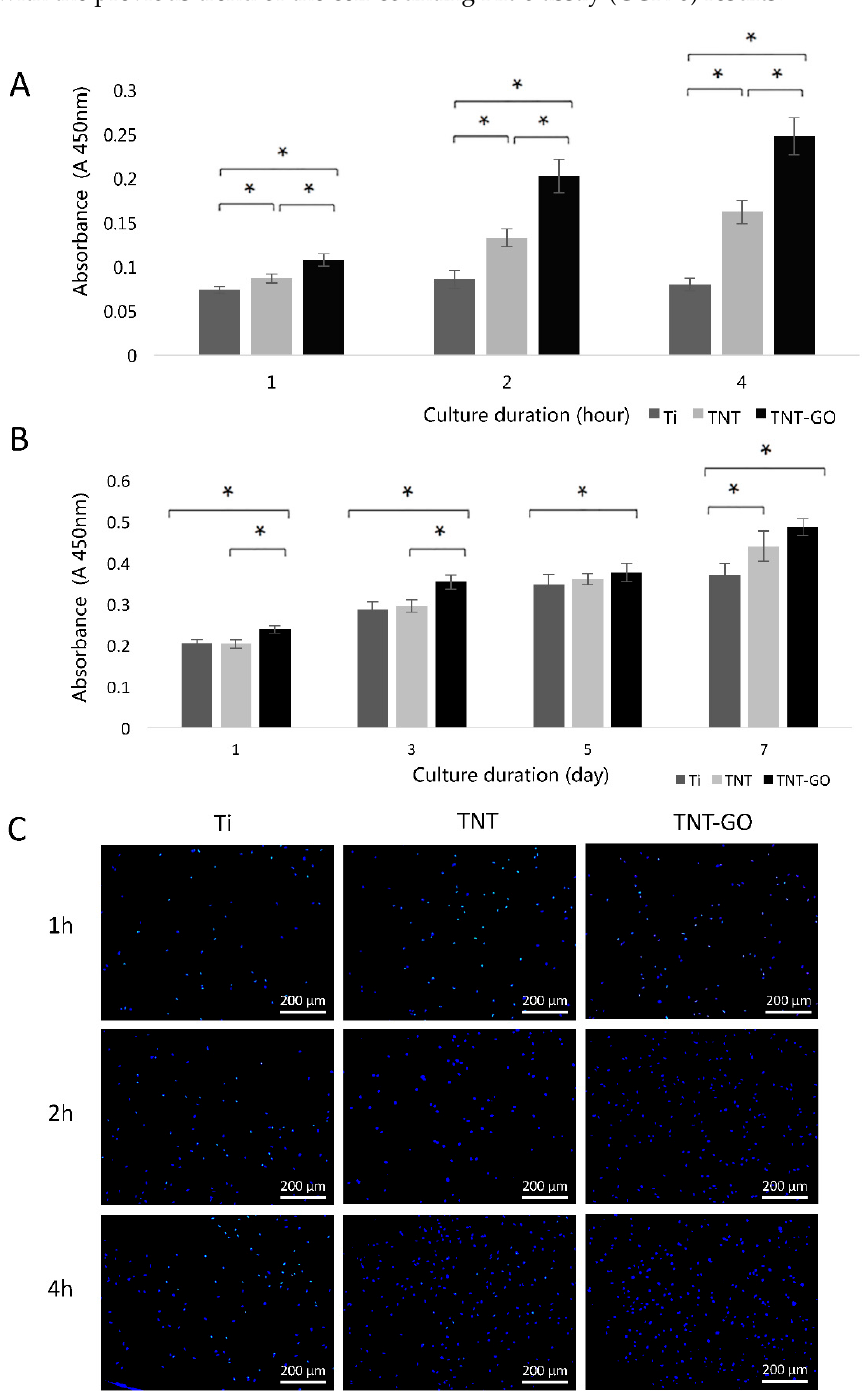
Figure 3. ( A ) Cell adhesion of human gingival fibroblasts (HGFs) on the samples after 1, 2, and 4 h. ( B ) Cell proliferation of HGFs after 1, 3, 5, and 7 d. ( C ) DAPI staining of adherent HGFs after 1, 2, and 4 h. (* p < 0.05).